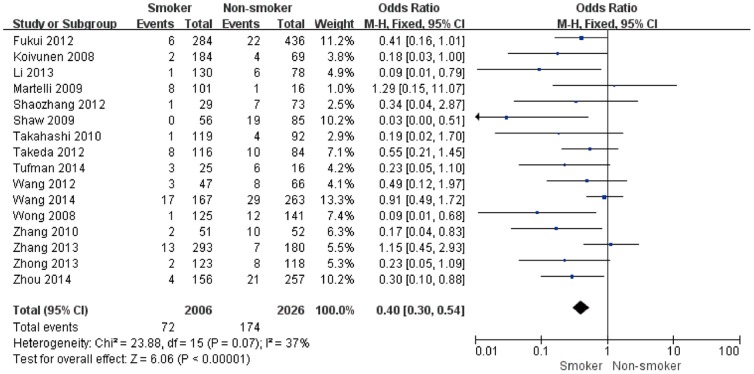
Forest plots of studies with an association between the EML4-ALK fusion gene and smoking status.